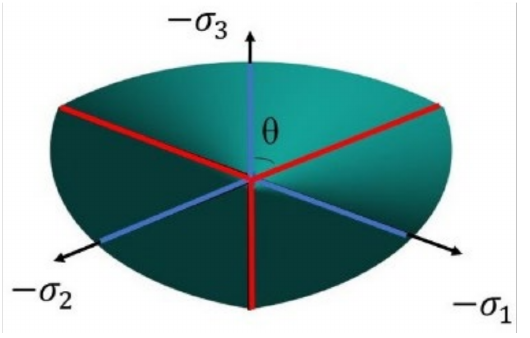
Figure 2. Deviatoric